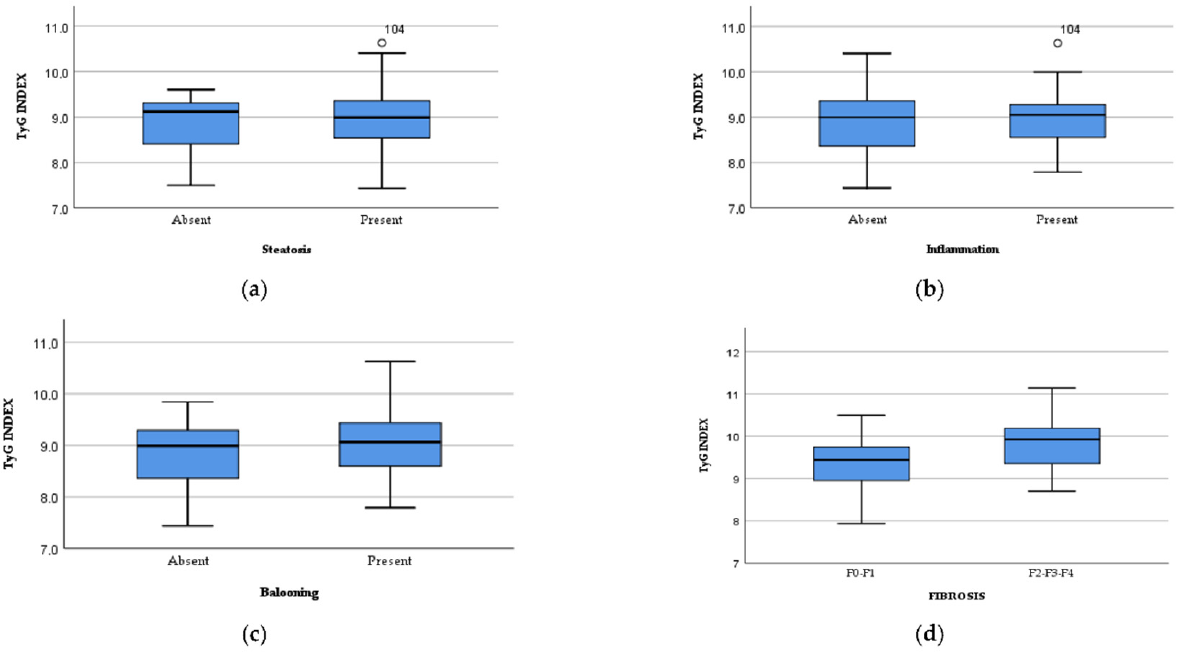
Figure 3. The study of the TyG index in relationship to ( a ) the presence of liver steatosis, ( b ) the presence of liver inflammation, ( c ) the presence of hepatocyte ballooning and ( d ) the degree of liver